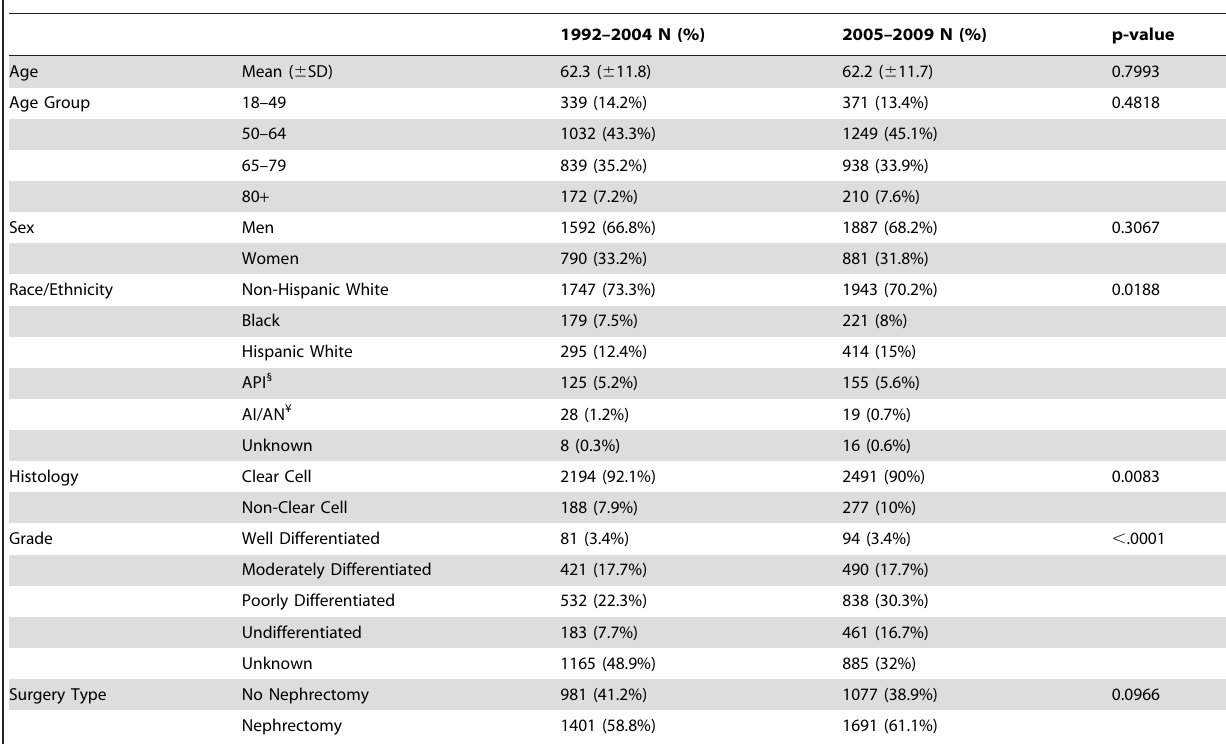
Table 1. Patient characteristics by treatment period.